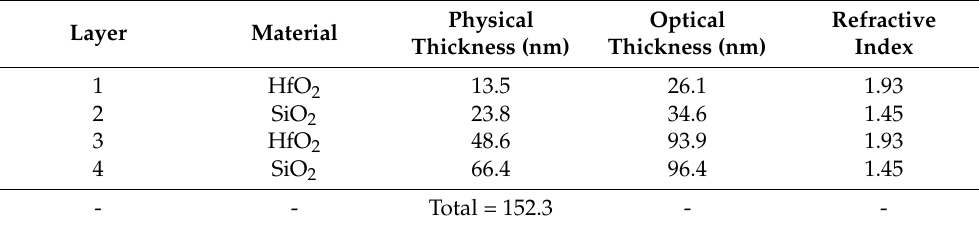
Table 4. Design of multilayer stack antireflection coatings at 355 nm